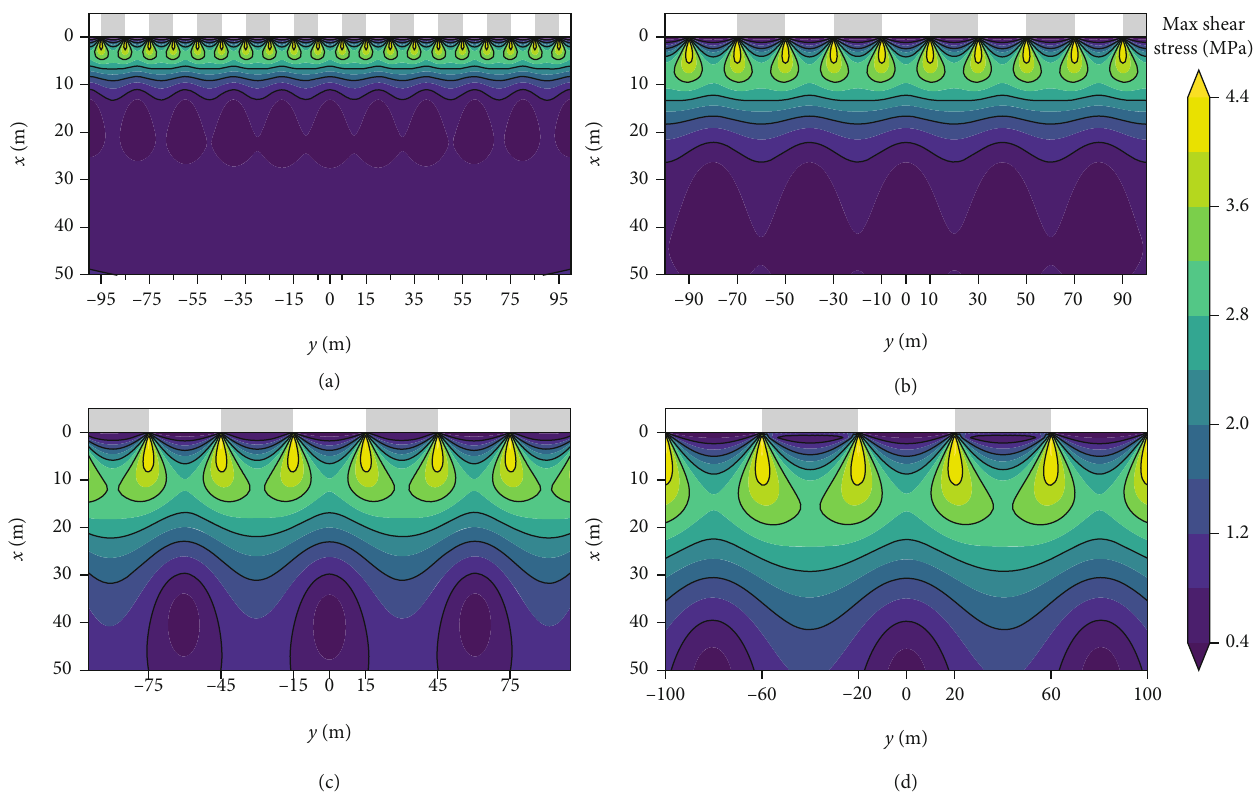
Figure 7: Cloud maps of maximum shear stress distributions when the width of the excavated coal pillar is (a) 10m, (b) 20 m, (c) 30 m, and (d) 40